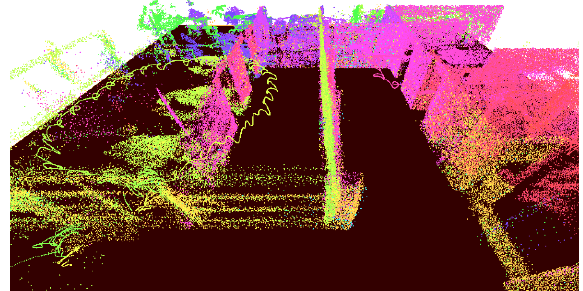
Figure 2. Trajectory and segments are colored by time. The different color of reflected surface and nearby trajectory is because of time difference.